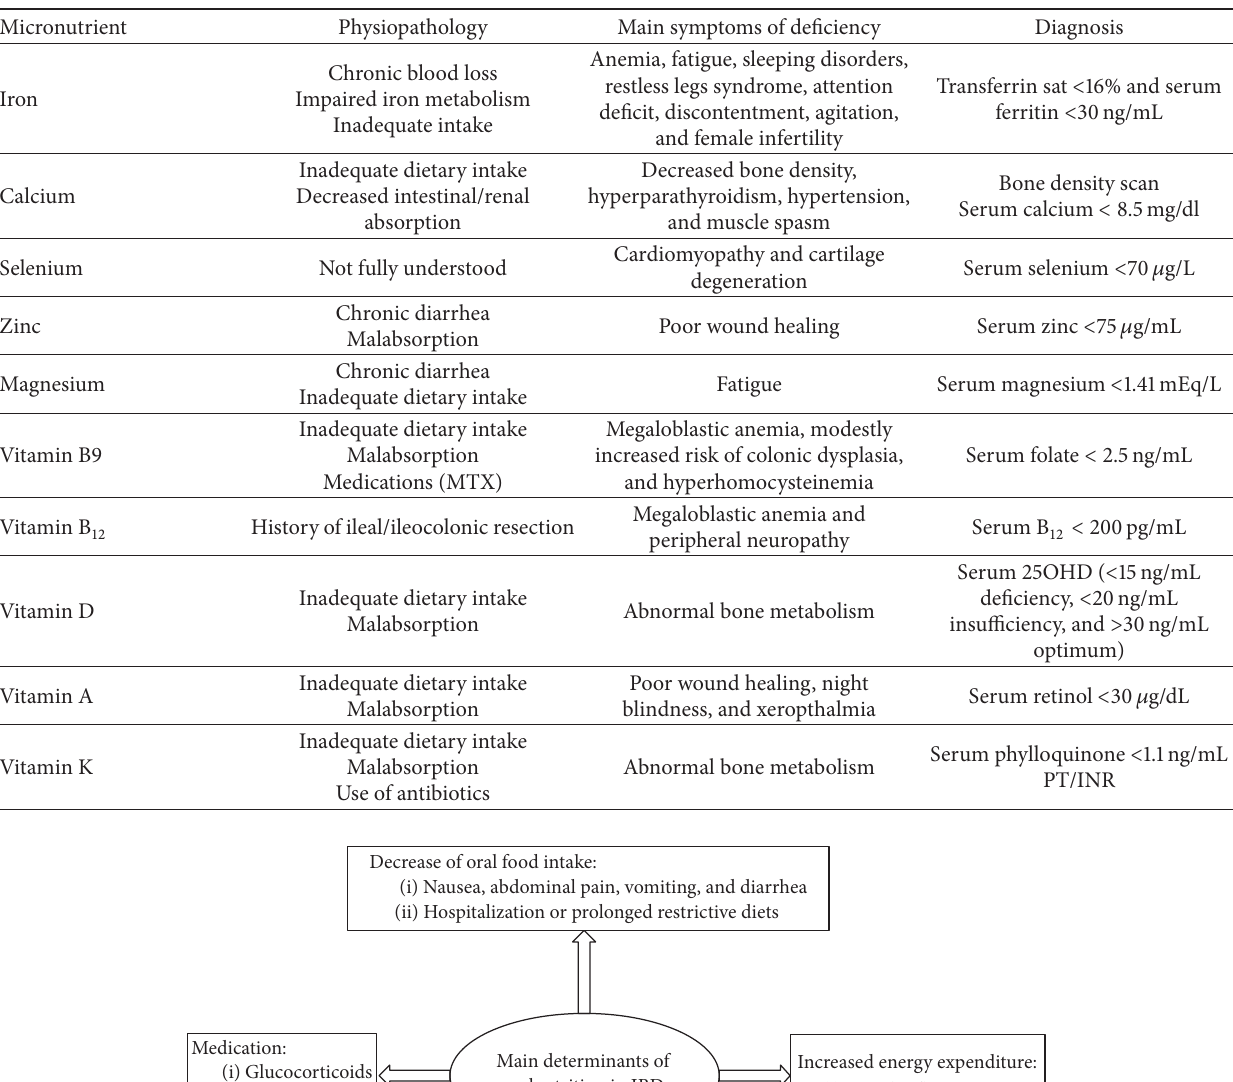
Table 1: Micronutrient deficiencies in IBD.